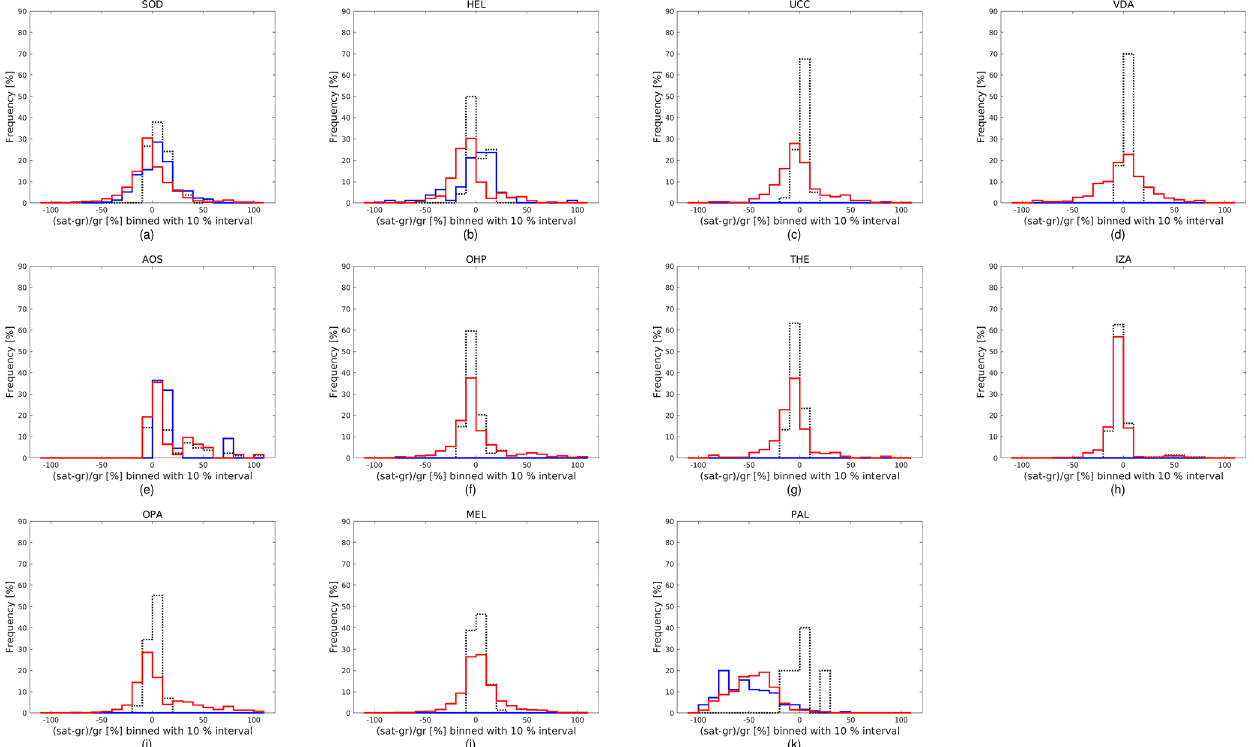
Figure 4. Histograms of relative difference between spectroradiometer measurements and satellite overpass erythemally weighted dose rates at (a) Sodankylä, (b) Helsinki, (c) Uccle, (d) Villeneuve d’Ascq, (e) Aosta, (f) Haute-Provence, (g) Thessaloniki, (h) Izaña, (i) Saint-Denis, (j) Melbourne and (k) Palmer. The black dotted line denotes cloud-free and the red one snow-free surface, and the blue line indicates snow cover on the